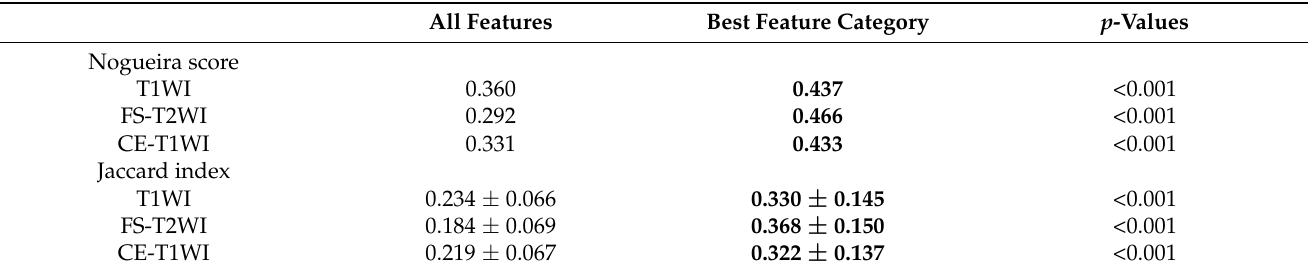
Table 3. Stability strength of feature selection based on different methods.